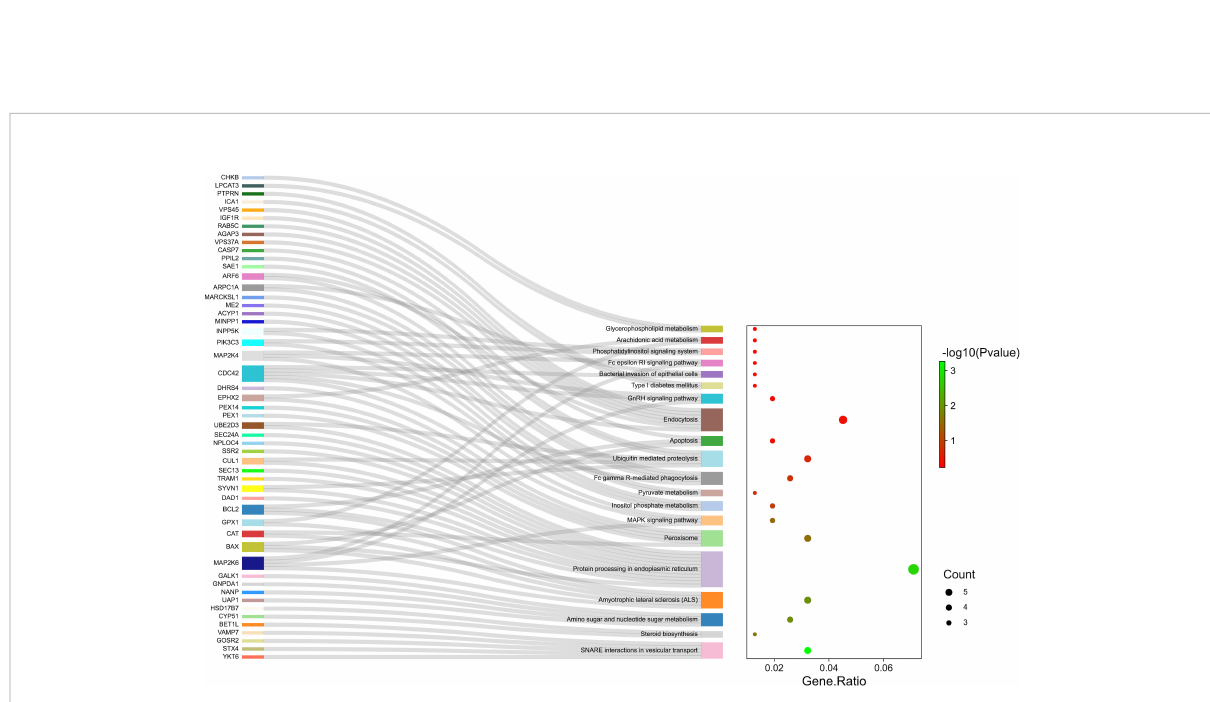
FIGURE 8 KEGG pathway enrichment analysis (n=3). The genes associated with the enrichment pathway are represented on the left. The bubble area size represented the number of genes belonging to the pathway in the target gene, and the bubble color represented the enrichment signi fi cance, i.e., the size of the P value. The top 10 pathways enriched by KEGG were shown in fi gure.